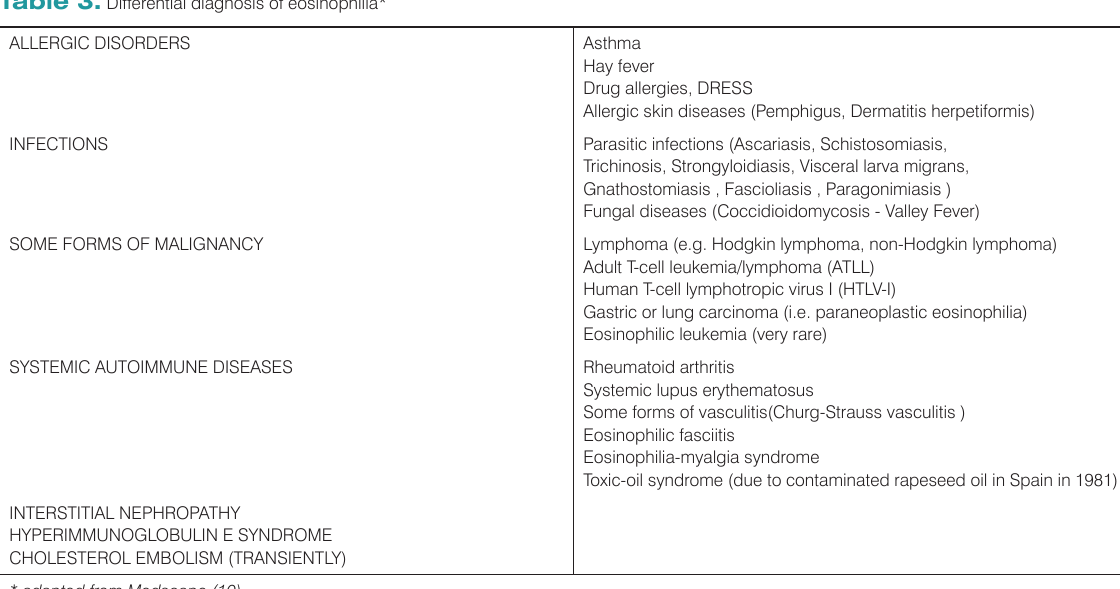
Table 3. Differential diagnosis of eosinophilia* ALLERGIC